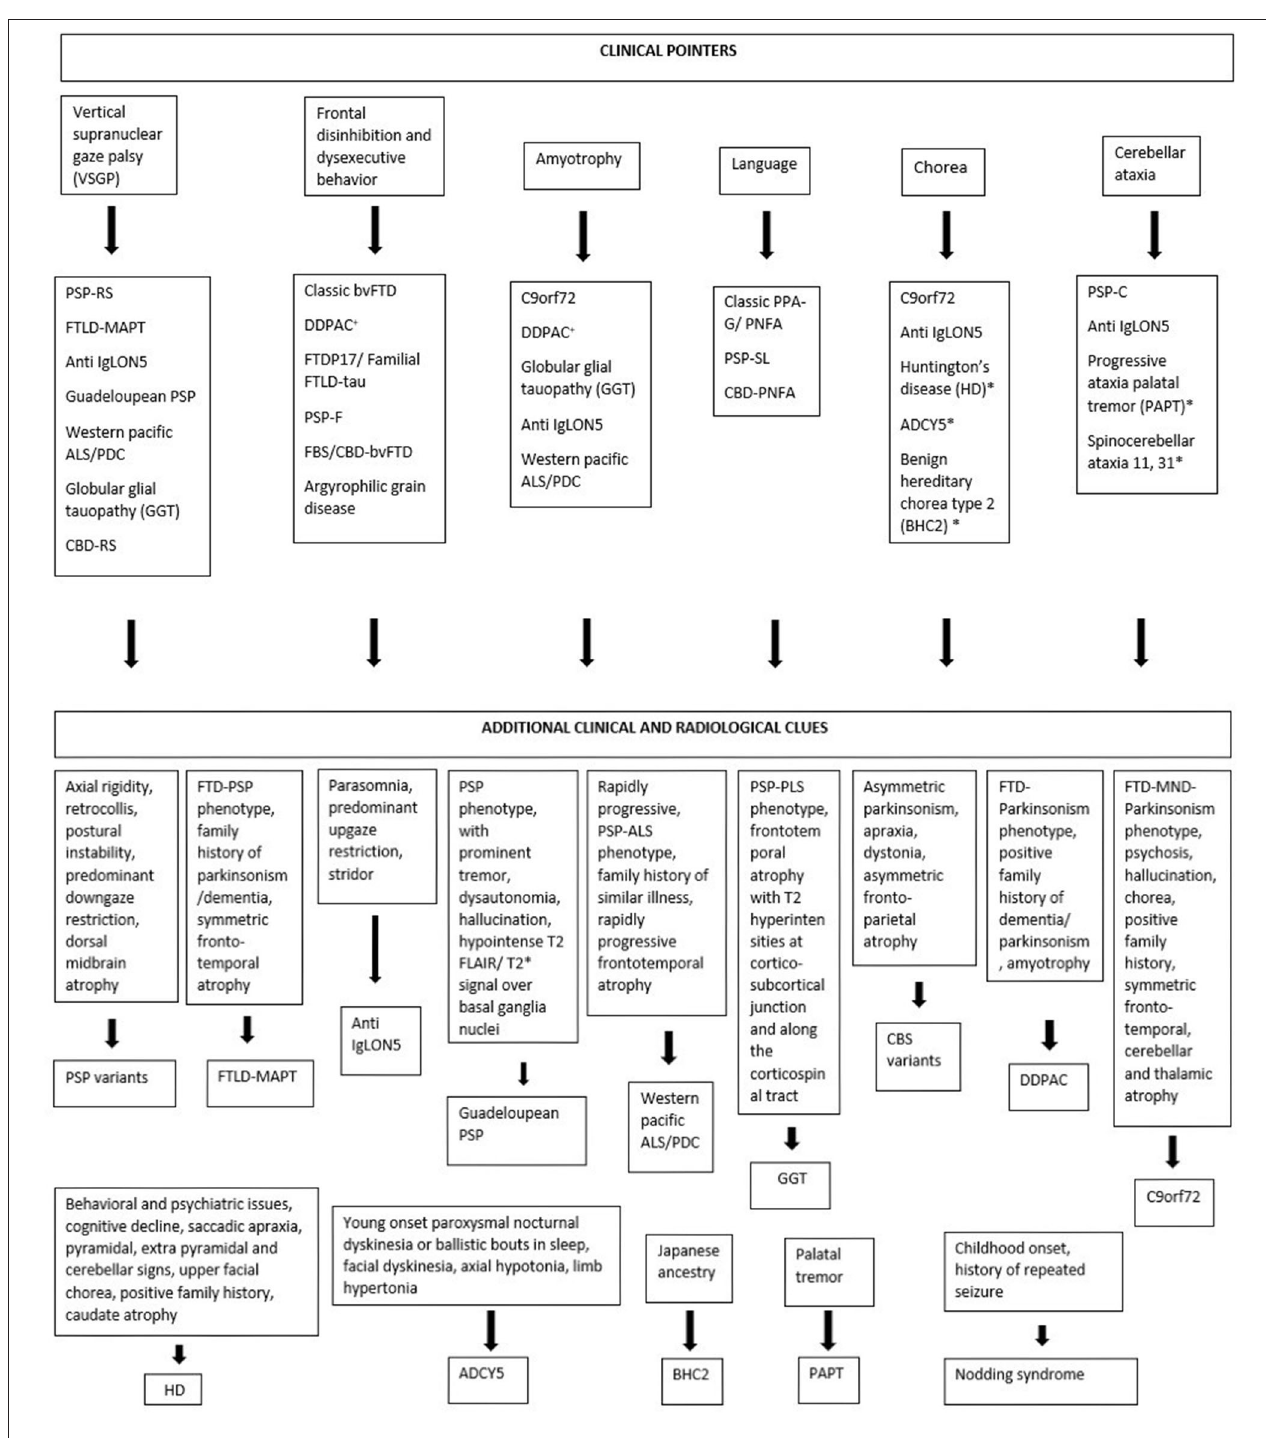
FIGURE 2 | Clinical pointers for diagnosing tauopathies. *Novel tauopathies, + DDPAC, disinhibition–dementia–parkinsonism–amyotrophy complex related to MAPT mutation (intron 10 + 14).